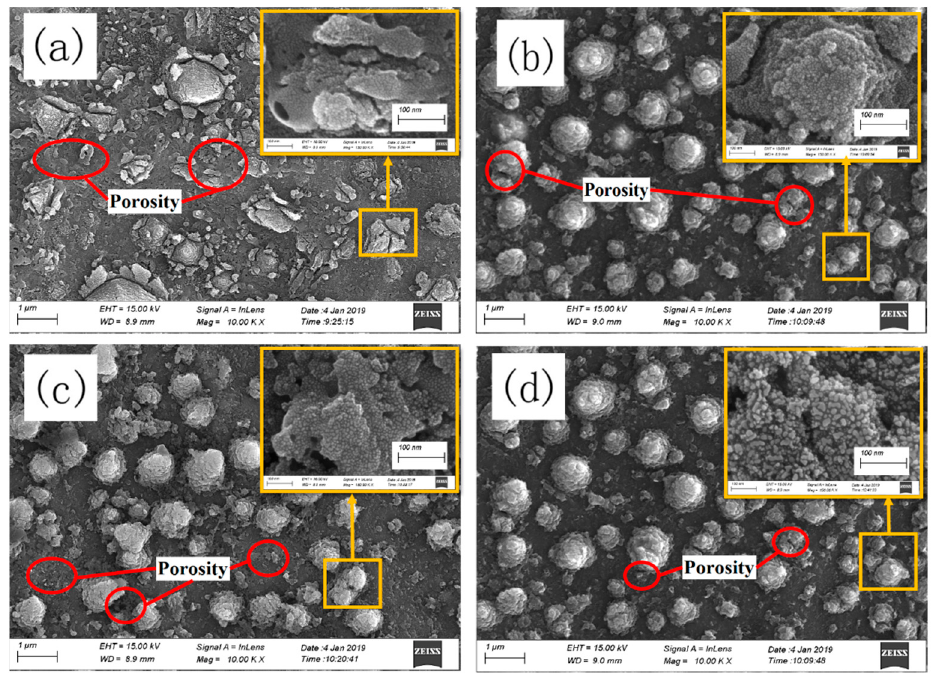
Figure 1. SEM view of the oxide surface for groups ( a ) X, ( b ) Y 1 , ( c) Y 2 and ( d ) Y 3 . Figure 2 represents the EDS results for the sample surface of groups X, Y 1 , Y 2 and Y 3 , respectively. As seen from Figure 2a–d, the prepared films are mainly made up of titanium and oxygen. The EDS spectrum of group X shows that Ti peaks are much higher than those of groups Y 1 , Y 2 and Y 3 . Groups Y 1 , Y 2 and Y 3 represent enrichment in oxygen with respect to the thermal oxidation time; the maximum enrichment was seen in group Y 3 . As reported elsewhere [19], the increment in the TiO 2 particles may be due to the existence of Ti vacancies in the film. According to Vennekamp et al. [20], the growth mode for the formation of TiO 2 is controlled by the movement of ionic species. If morphologically uneven growth occurs, then Ti ions are more mobile; once oxygen ions are mobile, stable growth is